Question: Does the figure show an increasing or a decreasing trend?
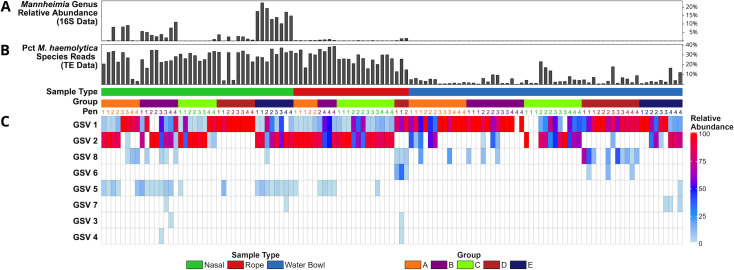
Answer: decreasing